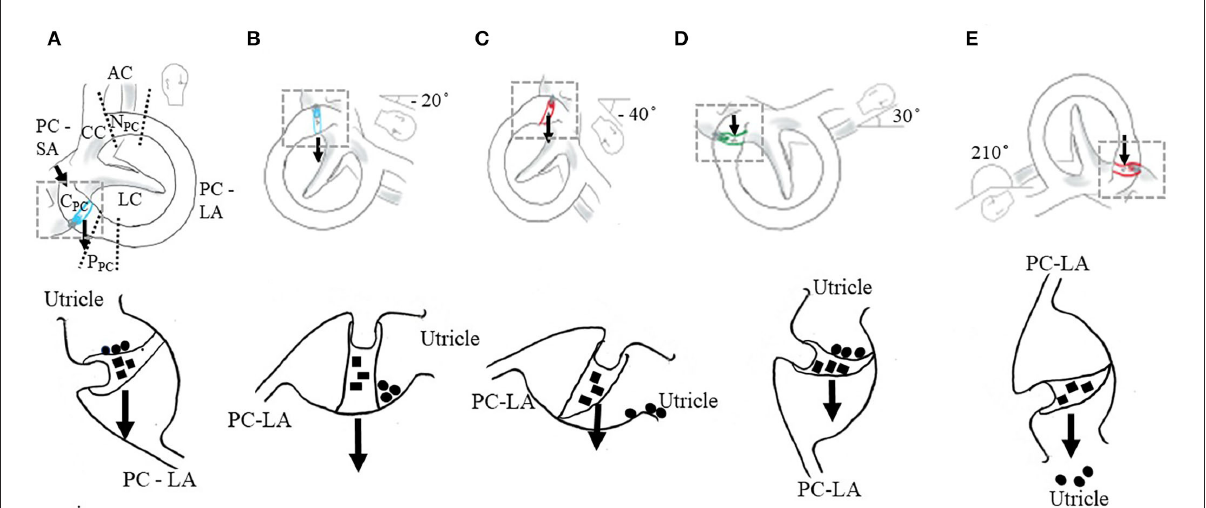
FIGURE1 Positional testing (top row) and proposed mechanisms of atypical nystagmus from the PC. The location of debris within canal–cupulolithiasis ( (cid:4) ) and canalithiasis of the short arm ( • ) (bottom row). Illustrated for the right membranous labyrinth. AC, anterior canal; LC, lateral canal; PC, posterior canal; CC, common crus; N PC , non-ampullary segment of PC (distal); P PC , periampullary segment of PC (proximal); and C PC , cupula of PC. The area of the PC between the CC and ampulla is the long arm (LA) and between the ampulla and the utricle is the short arm (SA). The PC long arm has two regions, the periampullary segment—proximal segment near the ampulla and the non-ampullary segment—distal segment near the common crus. Arrow indicates the line of gravity. (A–C) Right PC cupulolithiasis. The amount of head extension and flexion in the provoking position will vary the orientation of the axis of the PC cupula relative to the earth horizontal varying the amount and direction of nystagmus. (A) Initial position of the Dix-Hallpike test (DHT). In the sitting position, 45 ◦ neck rotation toward right (top row). No deflection of cupula. No nystagmus or symptoms (bottom row). (B) Head right DH position—recumbent position with the neck rotated 45 ◦ toward right and extended 20 ◦ below the earth horizontal (top row). Neutral position of ipsilateral PC cupula, the axis of the cupula is oriented in the earth vertical resulting in no nystagmus (bottom row). (C) Head right DH position with the neck extended 40 ◦ from the earth horizontal (top row). In the pronounced provoking position, the weight of the cupula causes the deflection of the cupula toward the utricle, inhibiting the PC afferent generating a constant, low-amplitude downbeat nystagmus (DBN) with or without torsion lateralized to the uninvolved side (bottom row). (D,E) Two earth horizontal positions for the right PC cupula oriented 180 ◦ to each other. (D) The right half Hallpike (HH) position—recumbent position with the neck rotated 45 ◦ toward right and flexed 30 ◦ from the earth horizontal. The right PC cupula axis is in the earth horizontal (top row). A weighted cupula causes a maximum deflection of the cupula toward the long arm resulting in the excitation of PC afferent generating an upbeat nystagmus (UBN) with torsion lateralized to the involved side (bottom row). (E) Inverted release (IR) position for the right PC cupula. Left side-lying position with the neck flexed 20 ◦ and rotated 45 ◦ down (top row). A weighted cupula causes a maximum deflection of the cupula toward the utricle, resulting in the inhibition of PC afferent generating a DBN with or without torsion lateralized to the uninvolved side (bottom